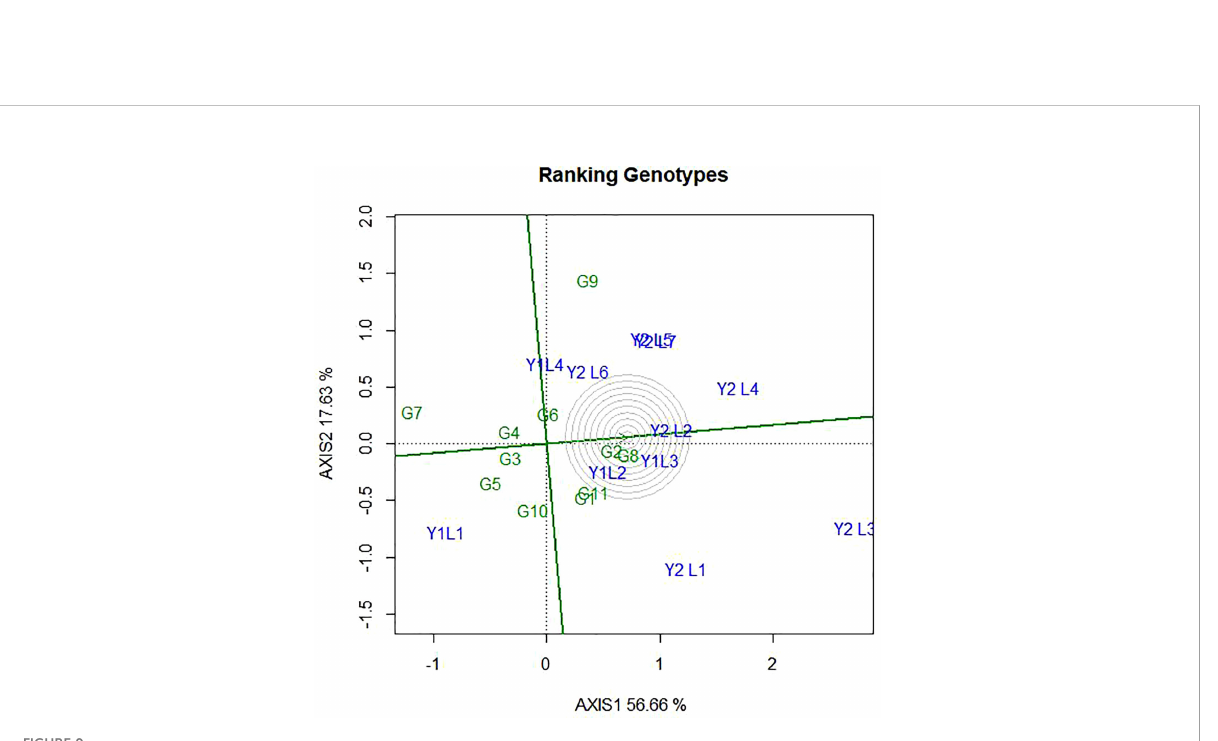
FIGURE 9 The GGE biplot ‘ Environment ranking ’ pattern for environment comparison with ideal environment showing G + G × E interaction effect of 11soybean genotypes under two years (11environemnets) for grain yield per hectare. The biplots were created based on Centering = 0, SVP = 2, Scaling =